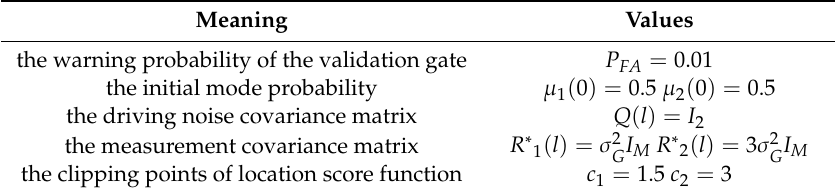
Table 1. The parameter settings for simulation.